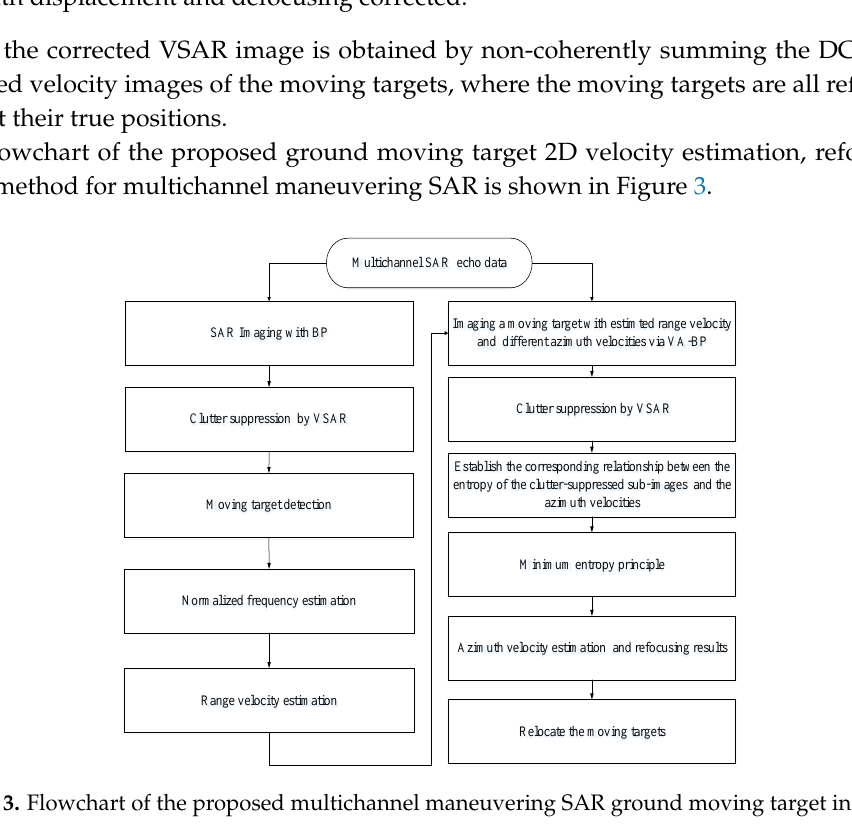
Figure 3. Flowchart of the proposed multichannel maneuvering SAR ground moving target indication (GMTI) method.